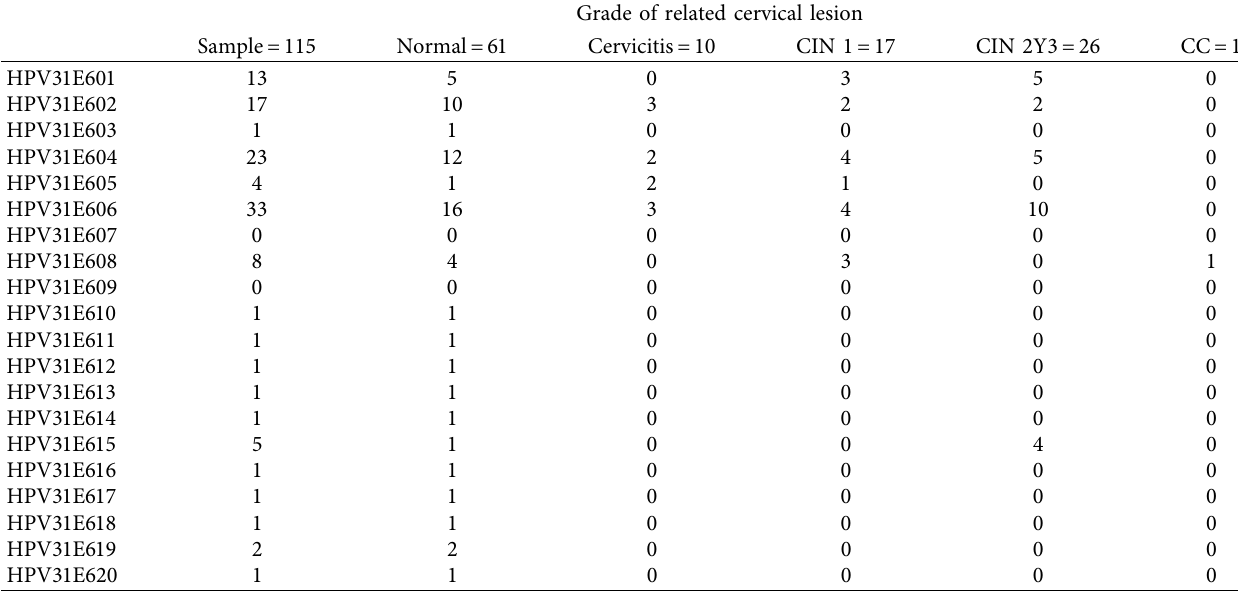
Table 6: Te associations of HPV31E6 variants with cervical disease.